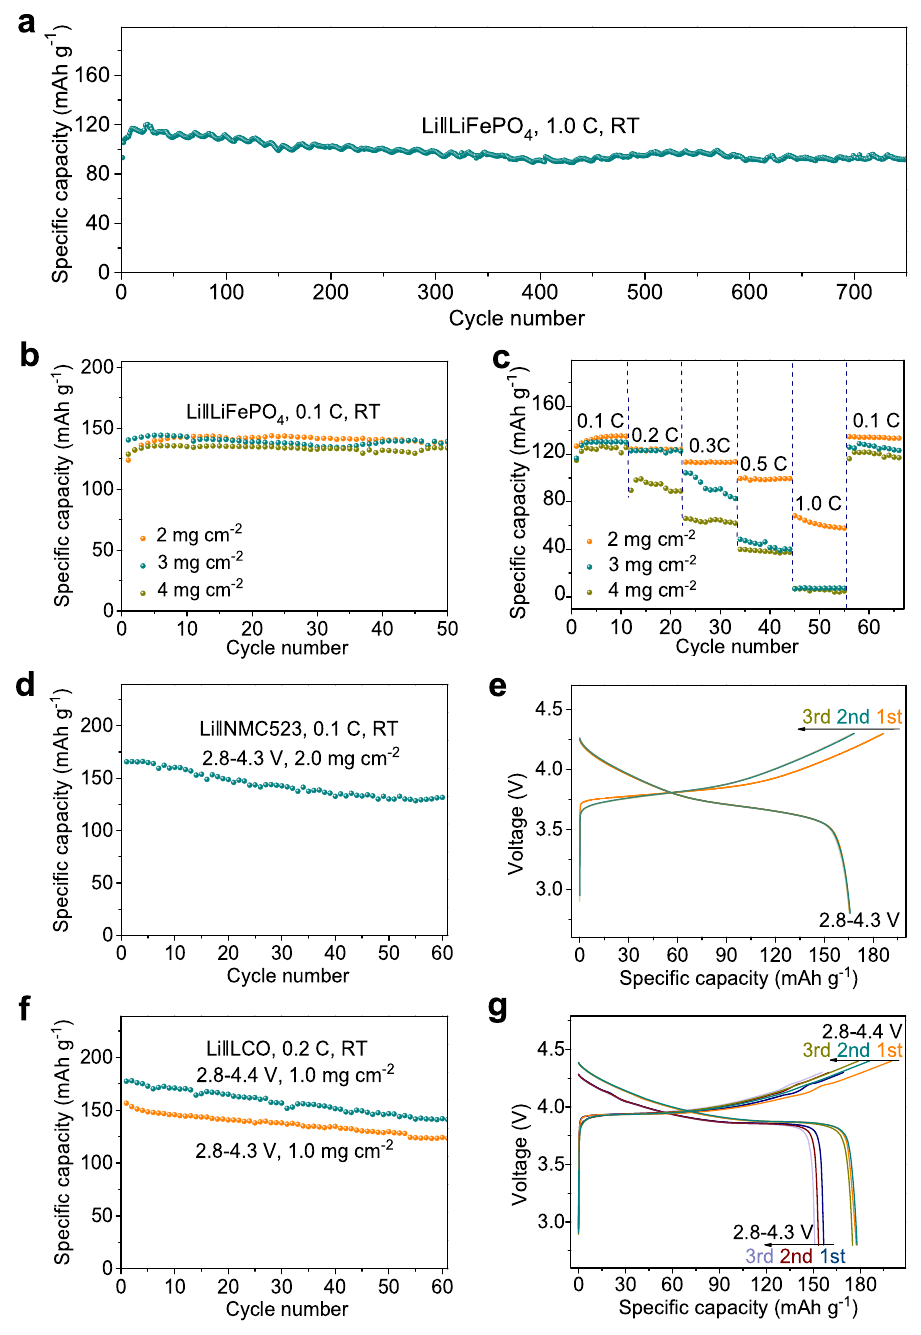
Fig. 5 Electrochemical cycling of the all-solid-state battery with Li-RCC1-ClO 4 catholyte. a Cycle performance of the all-solid-state cell with Li-RCC1- ClO 4 at 1.0 C under room temperature (loading: ~1.0 mg cm − 2 , oscillations are due to variations in the ambient temperature). b Cycling performance, and c rate performance of the SSLBs at room temperature with different LiFePO 4 areal loading. d Cycle performance and e voltage-capacity curves of the all-solid-state cell with NCM523 cathode during 2.8~4.3 V at 0.1 C under room temperature. f Cycle performance and g voltage-capacity curves of the all-solid-state cell with LCO cathode during 2.8~4.3 V and 2.8~4.4 V at 0.2 C under room